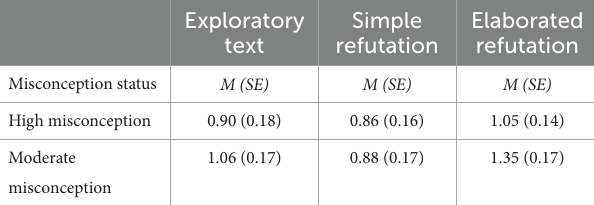
TABLE 3 Mean frequency and standard error for text type and misconception status for Transfer